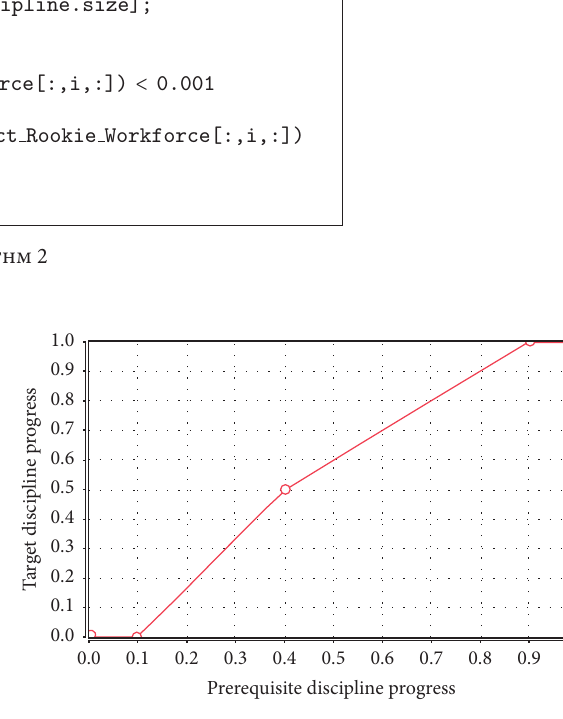
Figure 6: An example prerequisite